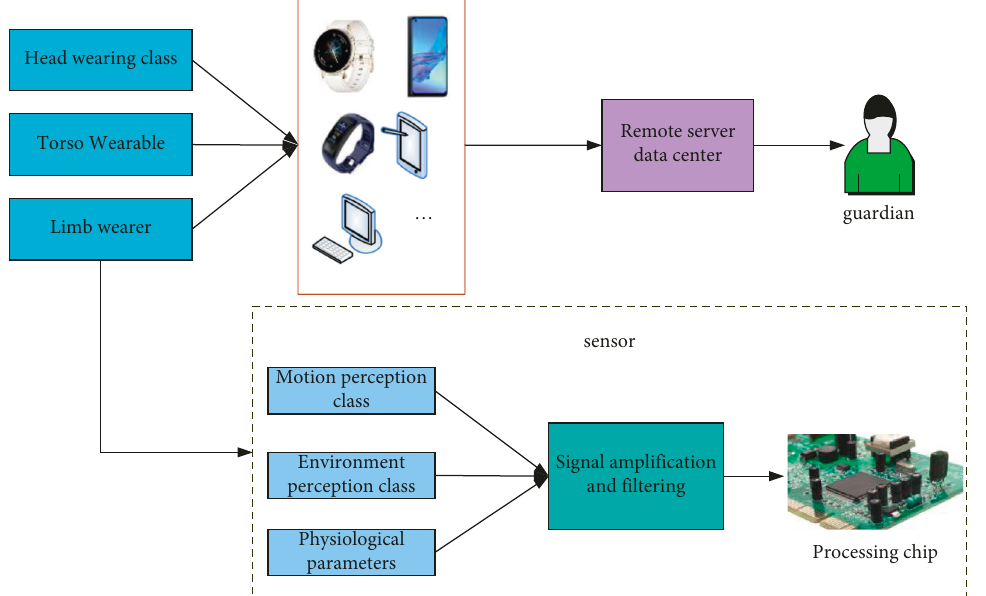
Figure 5: Multi-interaction information sharing framework